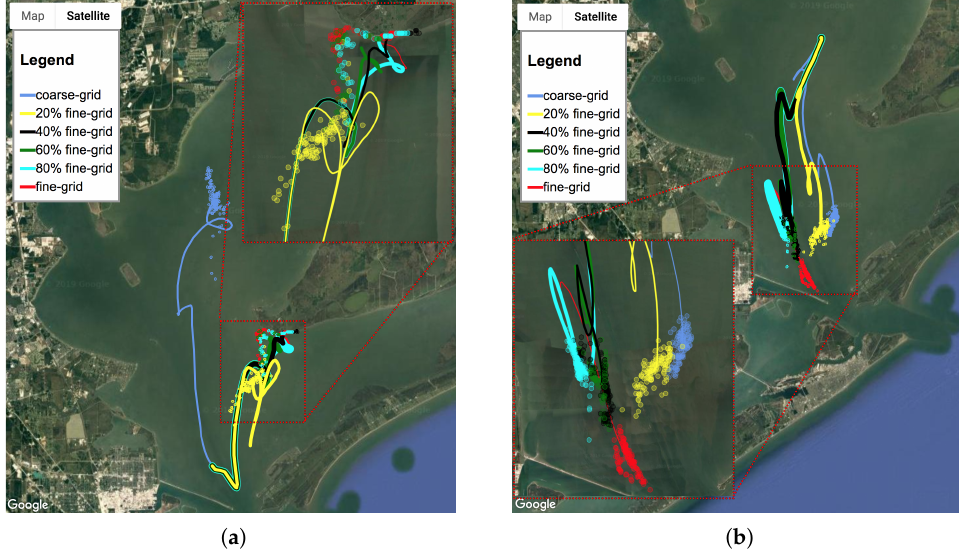
Figure 11. The trajectories of the multi-model integration for ( a ) Case 1 and ( b ) Case